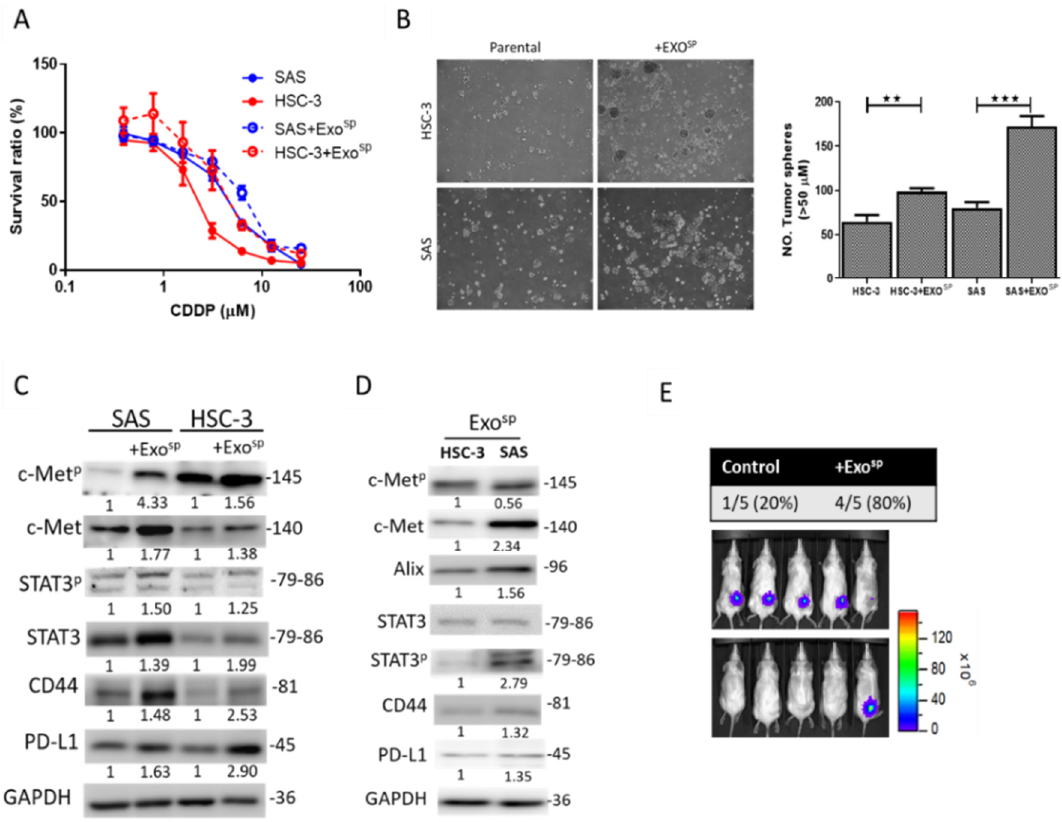
Figure 2. Tumorsphere-derived exosomes (Exo sp ) promoted the expression of c-Met/STAT3/CD44/PD-L1 expressions, CDDP resistance, and tumor-initiating ability in HNSCC cell lines. SAS and HSC-3 cells cultured with their respective Exo sp showed increased resistance to CDDP ( A ) and enhanced tumor sphere-forming ability ( B ) compared to their parental counterparts. Magnification 4X. ( C ) Western blot showing increased expressions of c-Met-associated signaling components, including c-Met p , STAT3, STAT3 p , CD44, and PD-L1 in both SAS and HSC-3 cells cultured with Exo sp . ( D ) Western blots of isolated Exo sp from SAS and HSC-3 cells indicated the presence of STAT3, c-Met, and their phosphorylated forms, PD-L1 and CD44. ( E ) Exo sp -transformed SAS cells demonstrated a significantly higher in vivo tumor-initiating ability compared to their parental counterparts. The numbers below the western blots indicate the relative expression ratio, normalized against the internal control (GAPDH). Superscripted P represents the phosphorylated form of c-Met and STAT3. The numbers on the right side of the Western blots indicate the molecular weights of the proteins being examined (in kD). ** p < 0.01, *** p < 0.001.